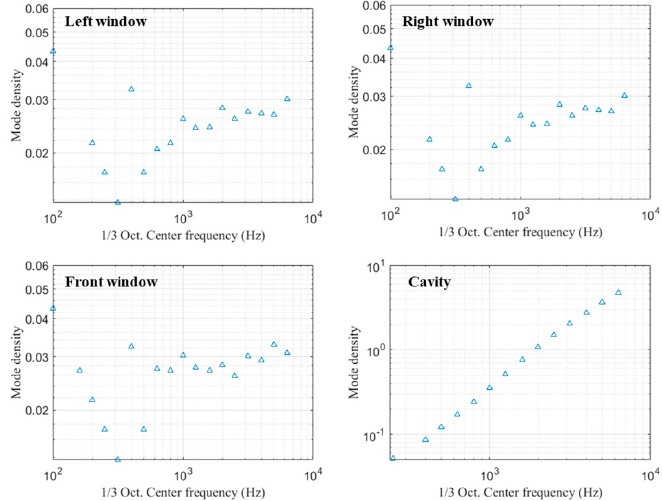
Figure 12. Mode density of side windows, front windshield, and cavity.